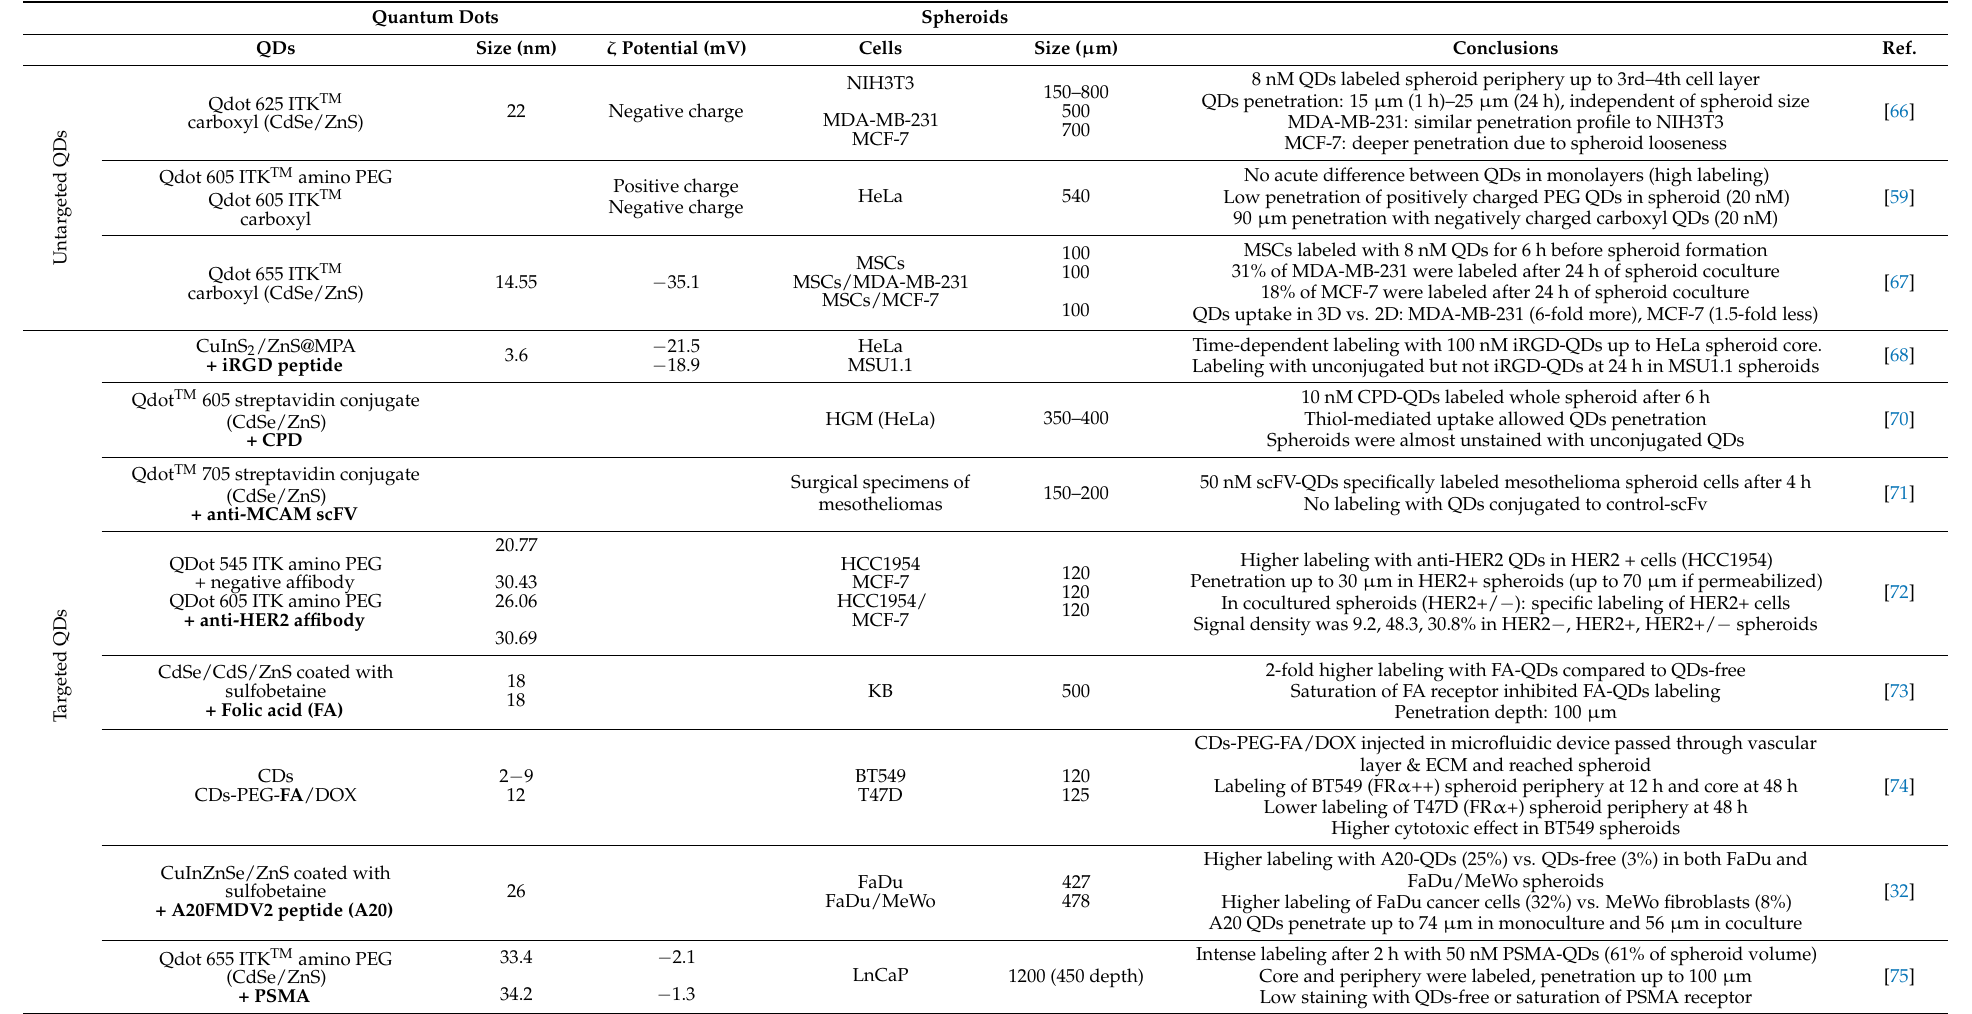
Table 1. Main parameters and conclusions reported using untargeted and targeted QDs as imaging agents in spheroid